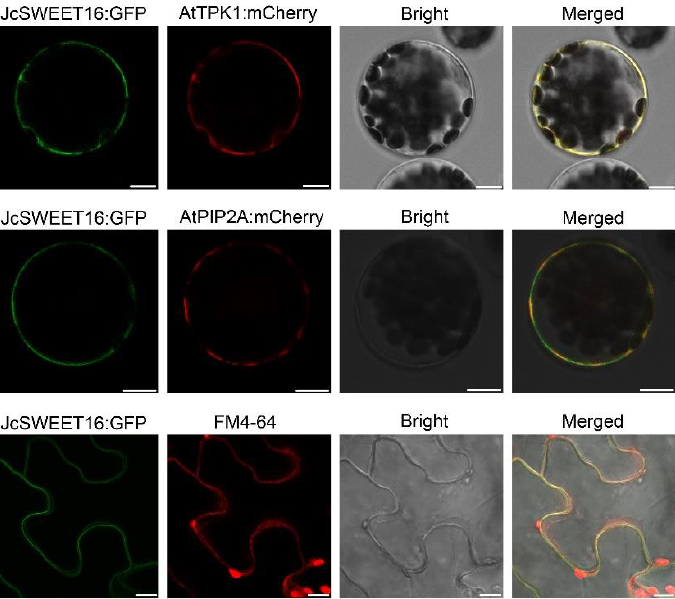
Figure 7. Subcellular localization of JcSWEET16 in A. thaliana mesophyll protoplasts and N. benthamiana leaves. Top two rows: confocal images of A. thaliana mesophyll protoplasts transiently expressing JcSWEET16:GFP fusions and the vacuolar membrane marker AtTPK1:mCherry or the plasma membrane marker AtPIP2A:mCherry, indicating localization to the vacuolar membrane and the plasma membrane. Bottom row: confocal images of N. benthamiana epidermal leaf cells transiently expressing JcSWEET16:GFP fusions. Green fluorescence of JcSWEET16:GFP, red fluorescence from FM4-64 labeling the plasma membrane and merged images are shown, indicating localization to the plasma membrane. Scale bar = 10 µm.